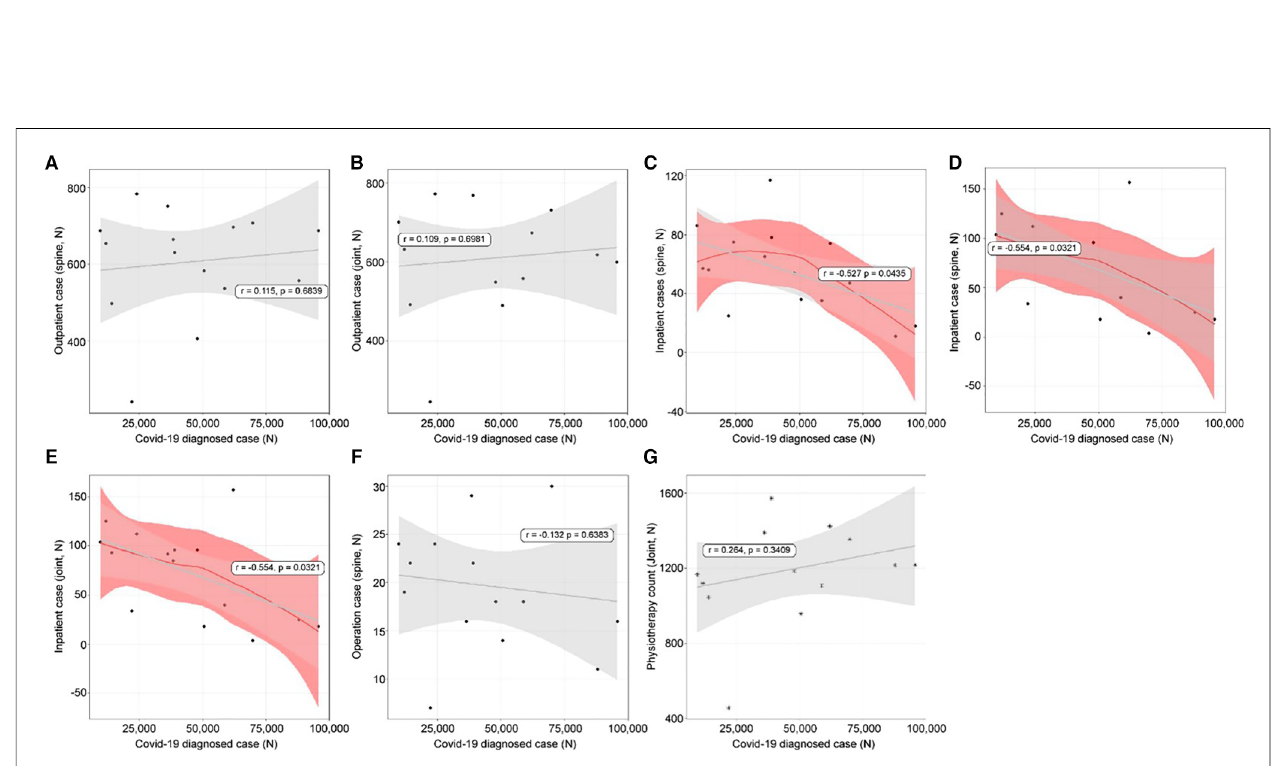
FIGURE 3 | The linear relationships between coronavirus disease 2019 (COVID-19) diagnosis and orthopedic hospital visiting patterns. ( A ) Spine outpatient count; ( B ) Joint outpatient count; ( C ) Spine inpatient count; ( D ) Joint inpatient count; ( E ) Spine operation patient count; ( F ) Joint operation patient count; ( G ) Physiotherapy patient